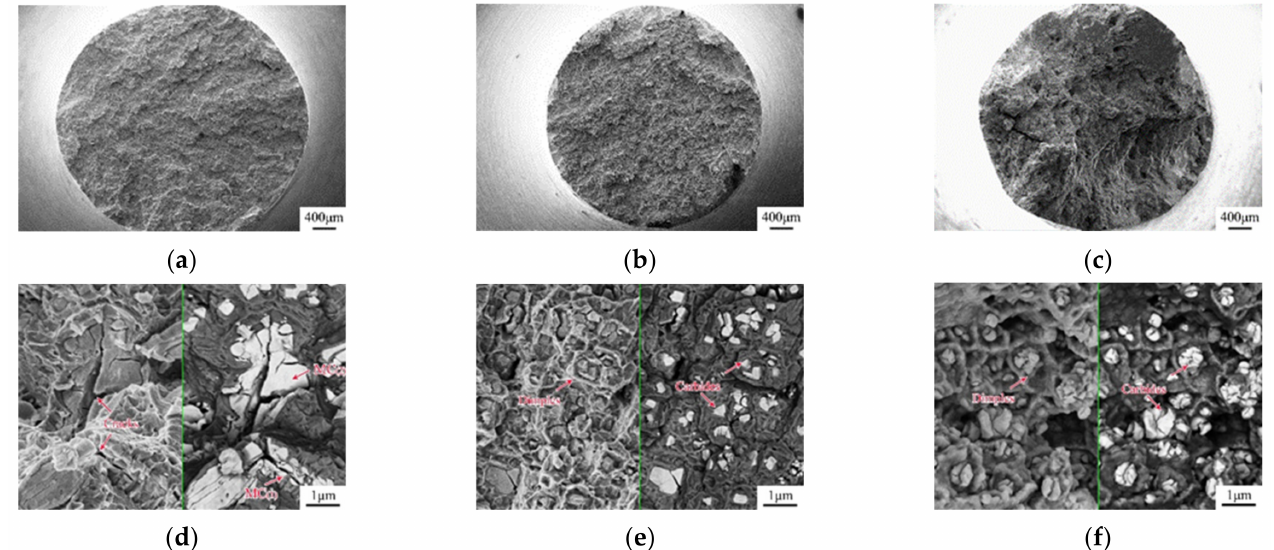
Figure 2. SEM images of fracture morphologies of DZ406 superalloy at a lower and higher magnifica- tion when tested at − 125 ◦ C ( a , d ), 25 ◦ C ( b , e ) and 1000 ◦ C ( c , f